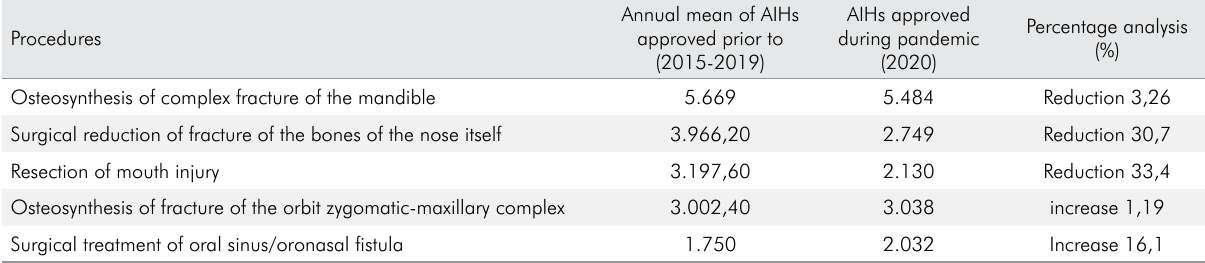
Calculation of the absolute frequency of the annual mean number of AIHs in the 5 most procedures most frequently performed in the study period (2015-2020) in comparison with the annual mean of 2020, in order to verify the reduction in and the percentage increase in hospitalizations during the pandemic year.